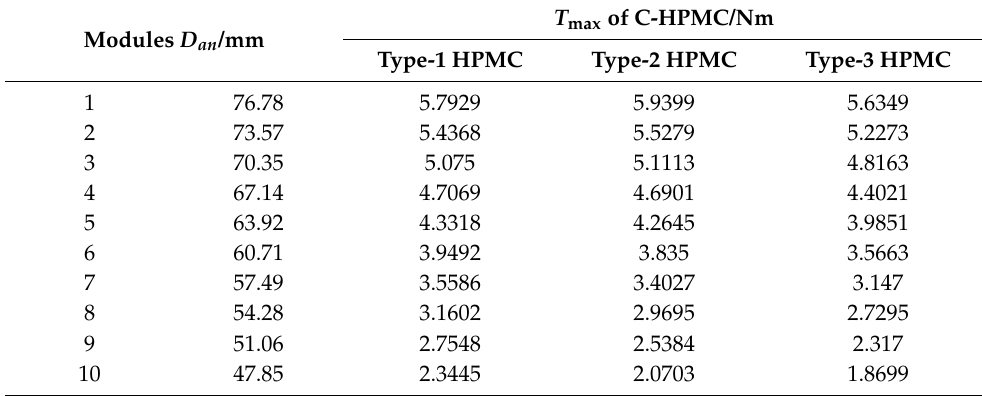
Table 3. T max of each module of